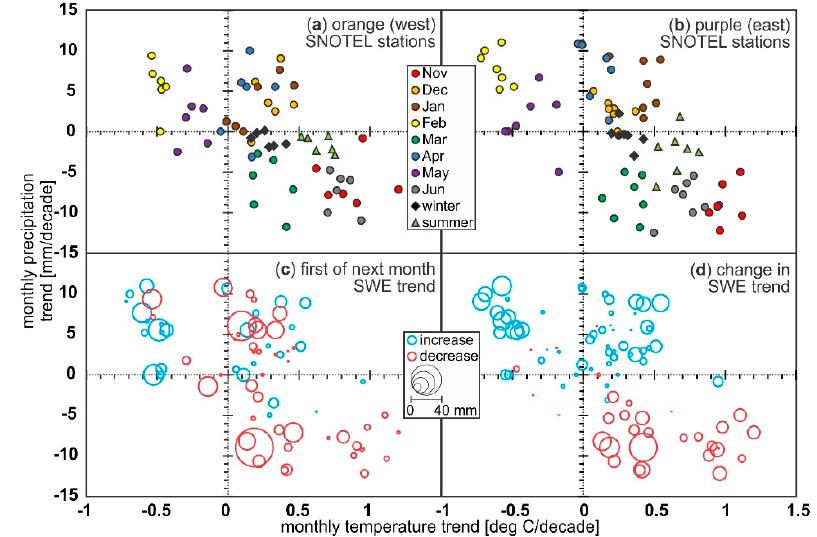
Figure 7. Correlation of monthly (and seasonal for winter, November through May, and summer, June through September) precipitation trend vs temperature trend from Snowpack Telemetry (SNOTEL) stations, divided by ( a ) west stations (Clow; orange group); and ( b ) east stations (Clow; purple group); The correlation of ( c ) first of the next month’s snow water equivalent (SWE) trend and ( d ) change in monthly SWE trend are presented as bubble size, divided into increasing (blue) and decreasing (red) for all stations on the plots of precipitation trend vs temperature trend.